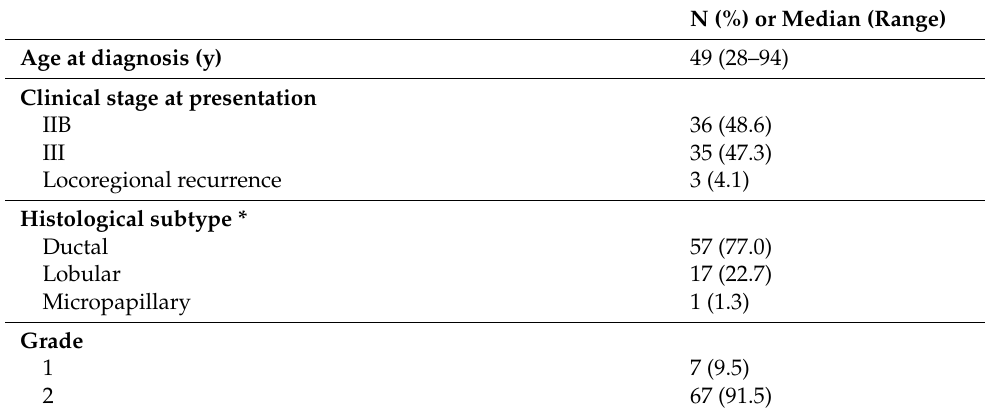
Table 1. Patient